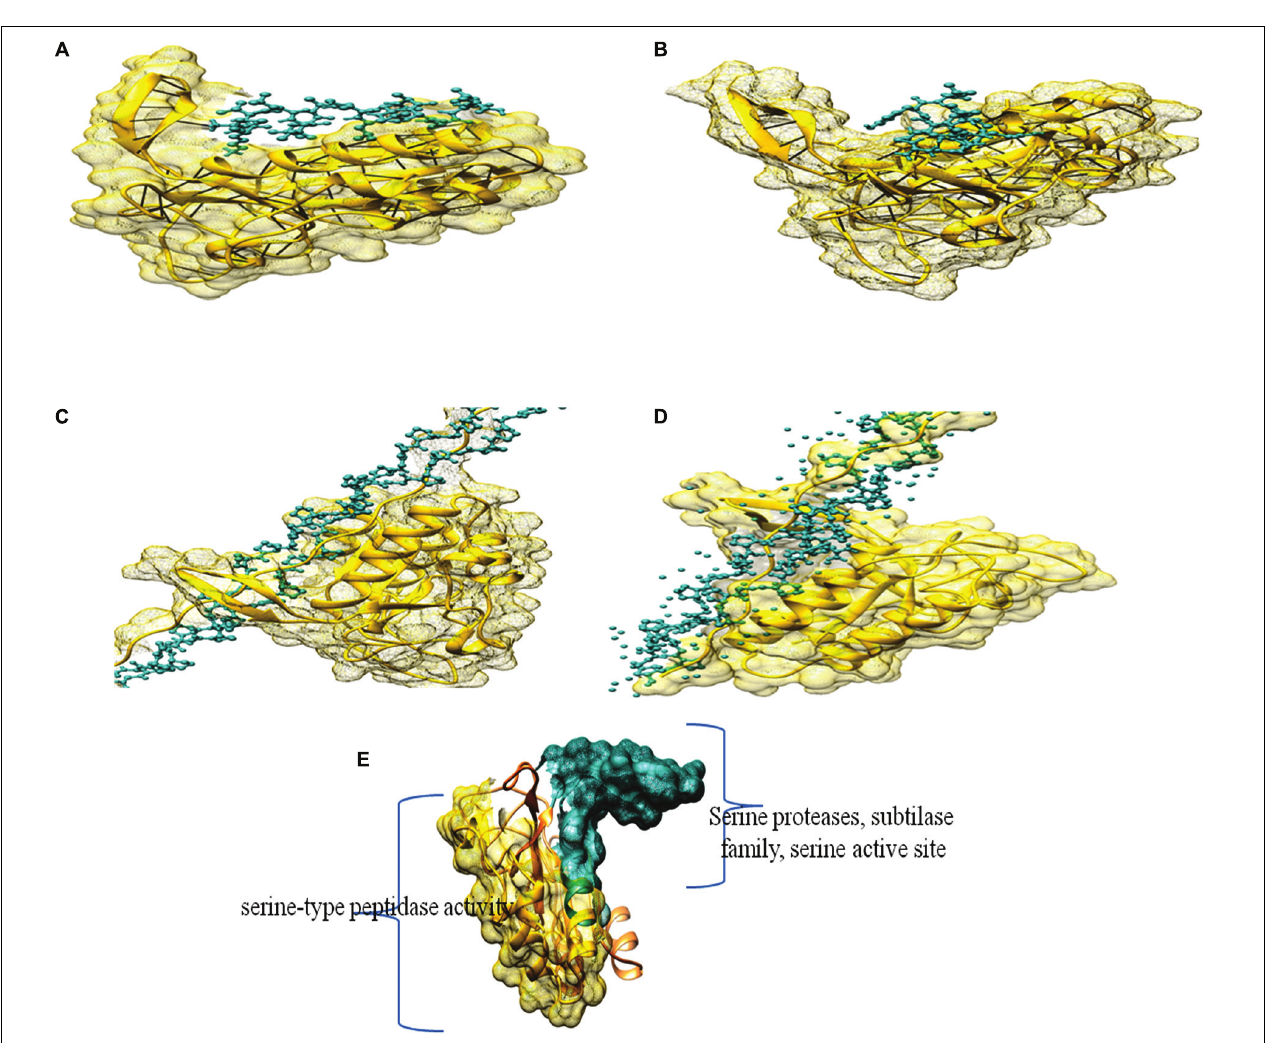
FIGURE 6 | Docking complex of modeled structure with (A) Casein, (B) Keratin, (C) Gelatin, (D) Azocoll, and (E) Domains of modeled structure from PRODOM.